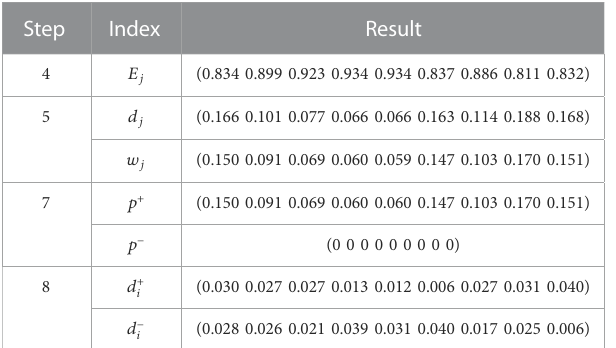
TABLE 4 Index calculation results.